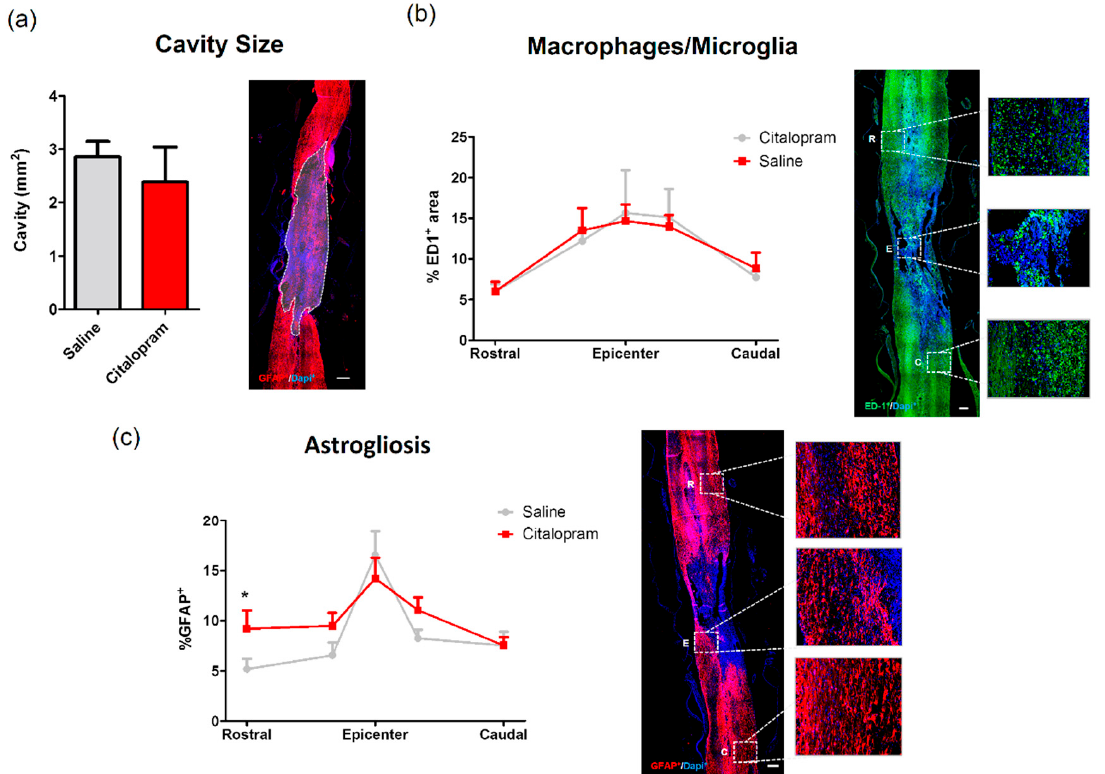
Figure 8. Impact of 8-week citalopram treatment on cavity size, macrophages / microglia and astrogliosis. ( a ) Analysis of the injury was performed by measurement of the% of the area occupied by the cavity using glial fibrillary acidic protein (GFAP) staining; ( b ) distribution of ED1 + cell area (macrophages / microglia) along the rostro–caudal axis of the spinal cord; ( c ) distribution of GFAP + cell area along the rostro–caudal axis of the spinal cord. Citalopram- n = 7 and vehicle-treated animals n = 8. Values shown as mean ± SEM. * p < 0.05.